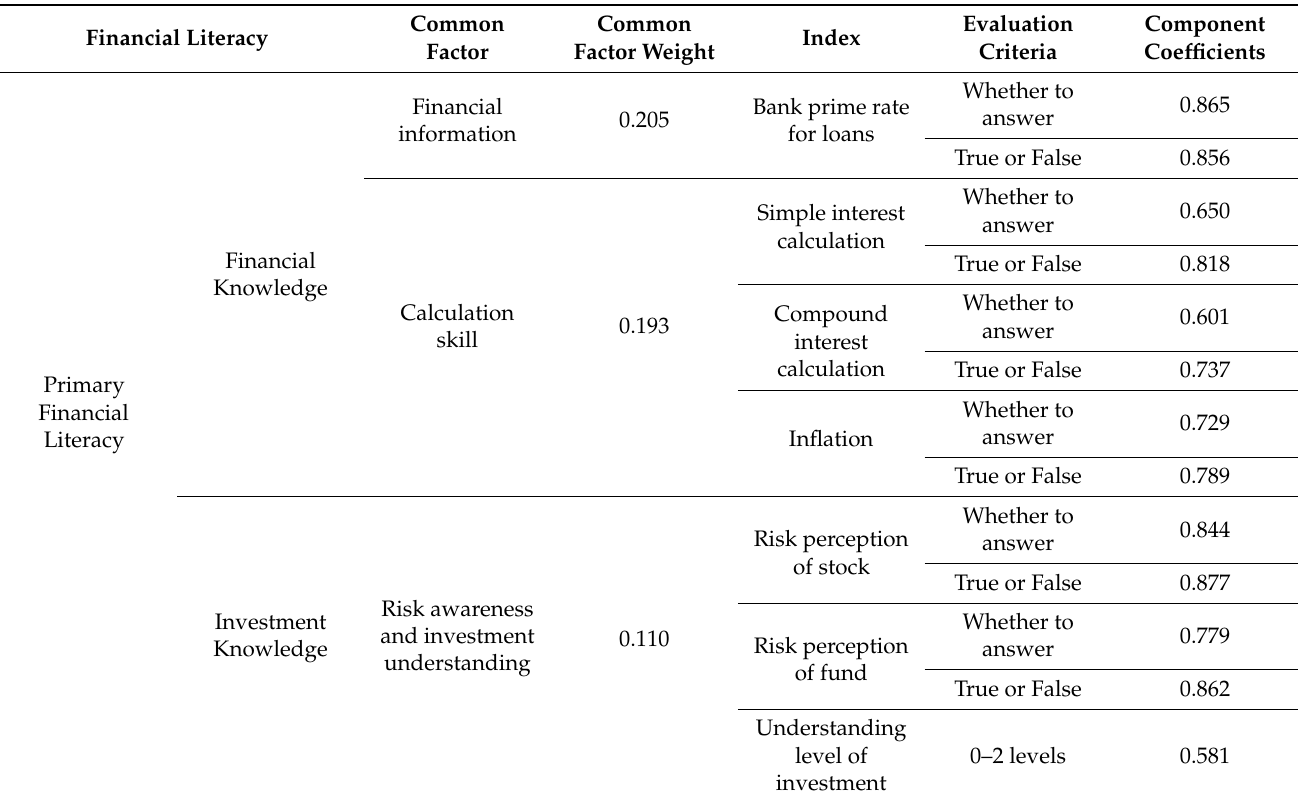
Table 1. Index system and factor analysis weights of financial